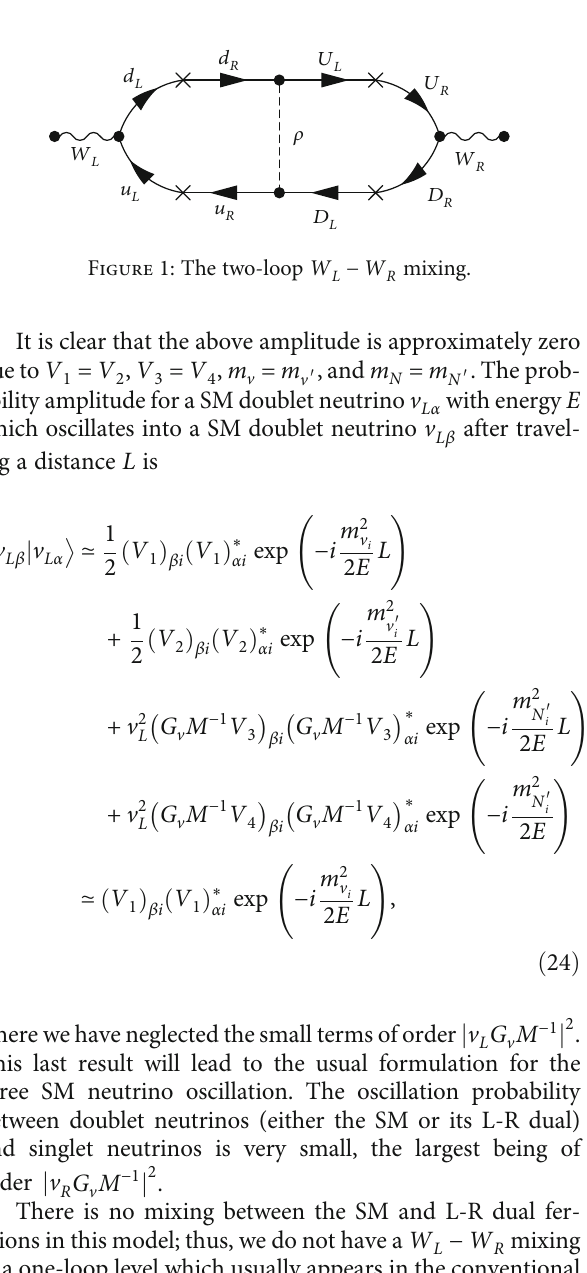
− W mixing. Figure 2: Process ρ L R